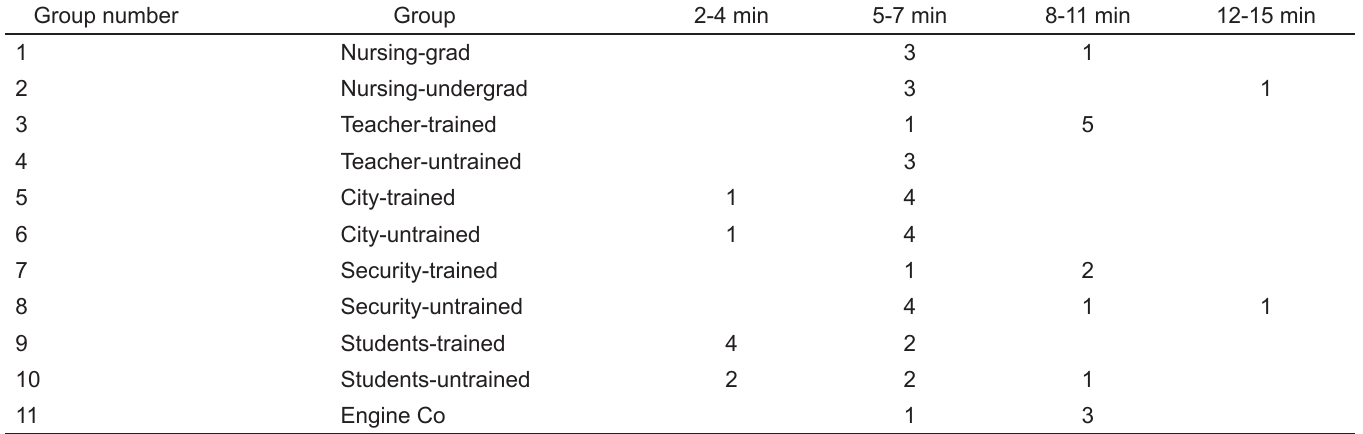
Table 2. Answers to Question 2 of the pre-test, organized by group number.